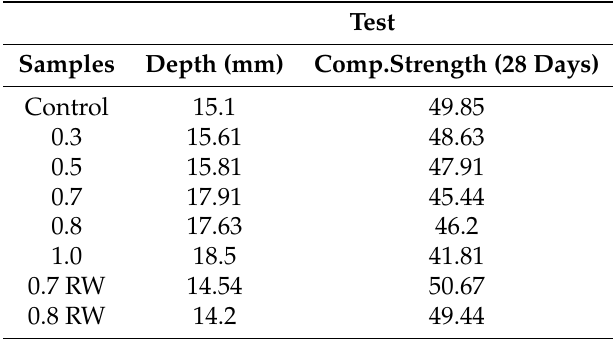
Table 4. Carbonation depth and compressive strength after carbonation.